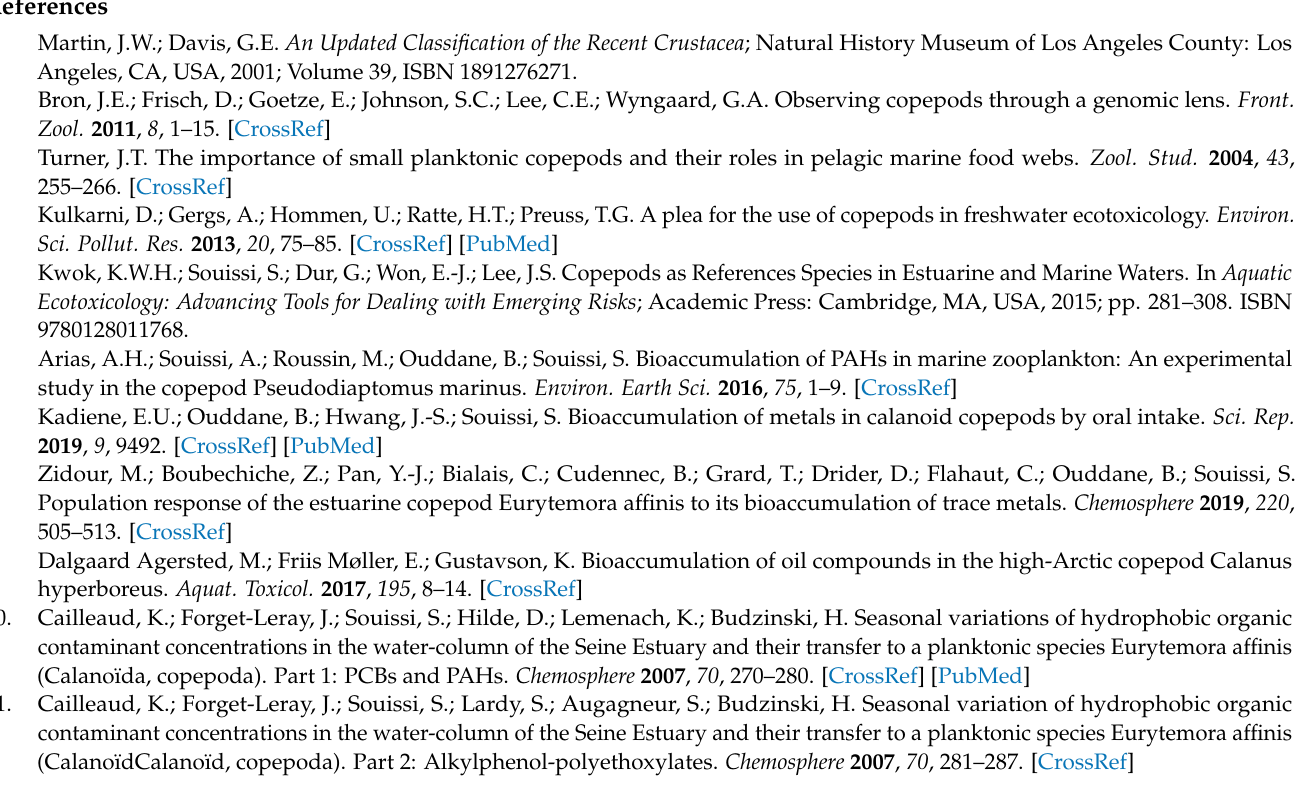
10.3390/genes12101484/s1, Figure S1: E. affinis mortality after exposure to tebufenozide (0.5 to